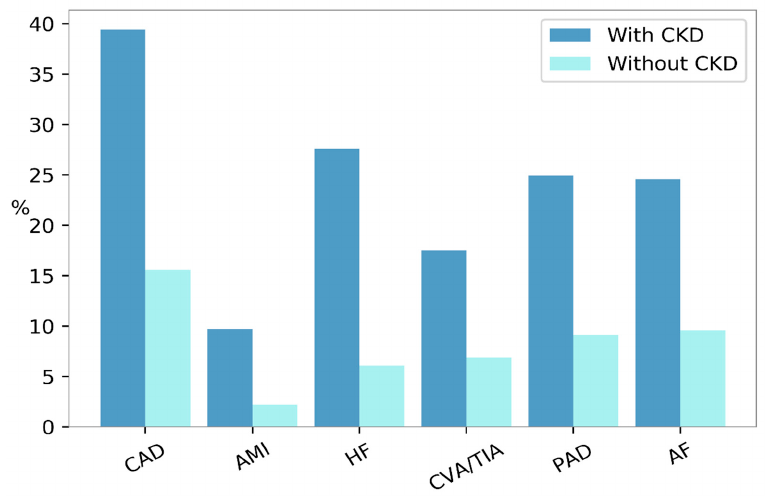
Figure 2. Prevalence of cardiovascular diseases according to the presence (dark blue bars) or absence (turquoise bars) of Chronic Kidney Disease (CKD) in the United States, in the year 2015. AF, atrial fibrillation; AMI, acute myocardial infarction; CAD, coronary artery disease; CVA/TIA, cerebrovascular accident/transient ischemic attack; HF, heart failure; PAD, peripheral arterial disease.